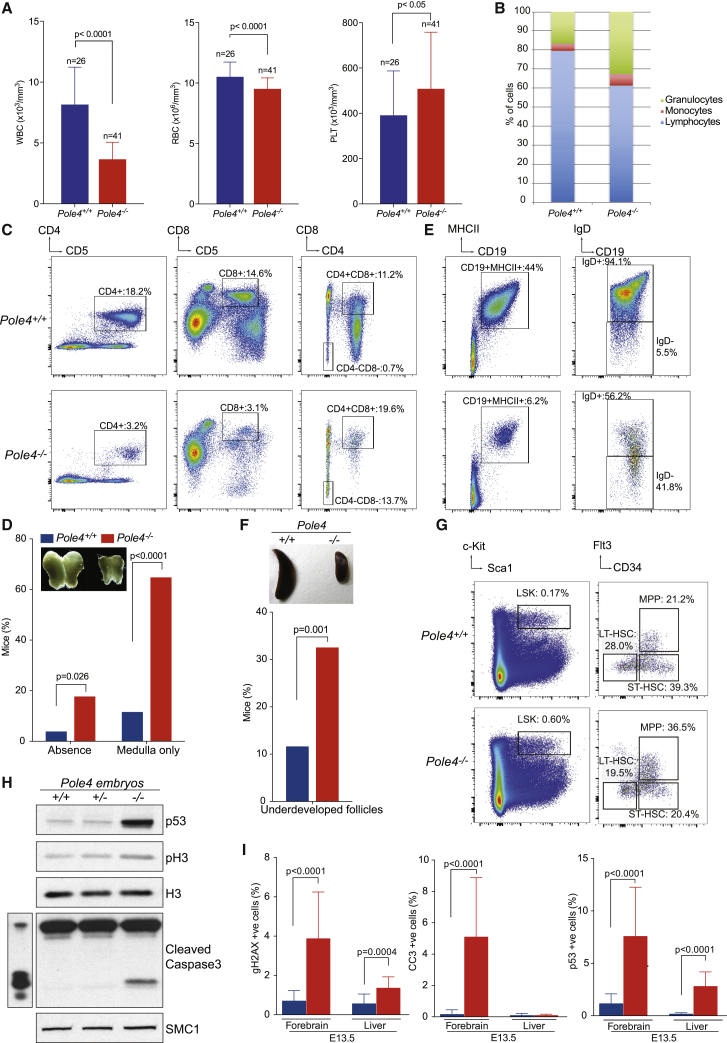
Loss of POLE4 Leads to Failed Lymphoid Progenitor Maturation following p53 Activation(A) White blood cell (left), red blood cell (middle), and platelet (right) counts in Pole4+/+ and Pole4−/− mice. n = 26 Pole4+/+ and n = 41 Pole4−/−. Significance: t test, p < 0.0001 for white blood cells (WBCs) and red blood cells (RBCs), p < 0.05 for platelets.(B) White blood cell distribution. Note the lower number of lymphocytes in Pole4−/− mice.(C) Representative flow cytometry plots of Pole4+/+ and Pole4−/− mice spleen gated on T lymphocytes and demonstrating a significant reduction of CD4+ and CD8+ single-positive cells and an increase in CD4−CD8− double-negative population. At least three animals have been analyzed per condition, and analyses were done in triplicates. CD5 was used as T cell marker(D) Frequency of Pole4+/+ and Pole4−/− mice presenting abnormal thymus. Note the size of Pole4−/− thymus is greatly reduced compared to WT littermates. Significance: Fisher’s exact test, p = 0.026 for thymus absence, p < 0.0001 for thymus with medulla only. n = 36 Pole4+/+ and n = 36 Pole4−/−.(E) Representative flow cytometry plots of Pole4+/+ and Pole4−/− mice spleen gated on B lymphocytes and demonstrating a significant reduction of CD19+ cells and an increase in IgD− population. At least 3 animals have been analyzed per condition, and analyses were done in triplicates.(F) Top: representative picture of spleen from Pole4 mice. Note the reduction in size following deletion of Pole4. Bottom: frequency of Pole4+/+ and Pole4−/− mice presenting spleen with underdeveloped follicles. n = 36 Pole4+/+ and n = 36 Pole4−/−. Significance: Fisher’s exact test, p = 0.001.(G) Left: representative flow cytometry plots of Pole4+/+ and Pole4−/− mice bone marrow gated on Lin-Sca1+cKit+ hematopoietic stem cells (HSCs) and demonstrating an increase of HSCs in Pole4−/− mice. Right: Pole4+/+ and Pole4−/− mice bone marrow gated on CD34 and Flt3 illustrating a decrease of long-term and short-term HSCs and an increase of multipotent progenitors in Pole4−/− mice. At least three animals have been analyzed per conditions, and analyses were done in triplicates.(H) Western blot analysis of proliferation and apoptosis in Pole4+/+ and Pole4−/− embryos at 13.5 dpc. Note the increased expression of p53 and caspase 3 cleavage in Pole4−/− extracts. SMC1 was used as loading control.(I) Immunohistochemistry quantification of γH2AX, cleaved caspase 3, and p53 in forebrain, and liver section of 13.5 dpc embryos. Significance: t test.